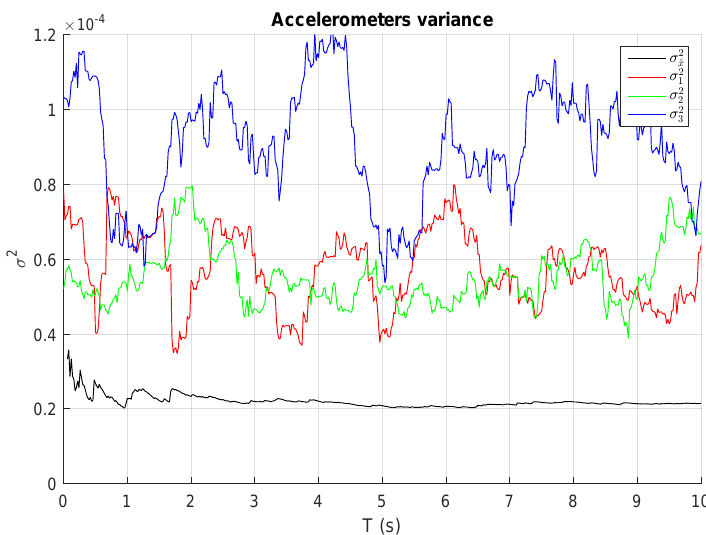
Figure 13. Individual measurement variances and sum block variances of the three accelerometers in steady state with adaptive weighting factors.